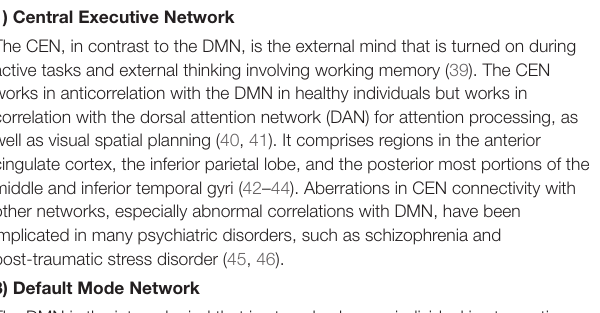
TABLE 1 | Seven major brain